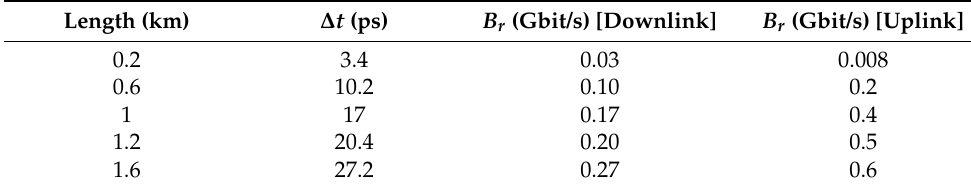
Table 4. Measured pulse broadening and supportable bit rate in the proposed scheme. Length